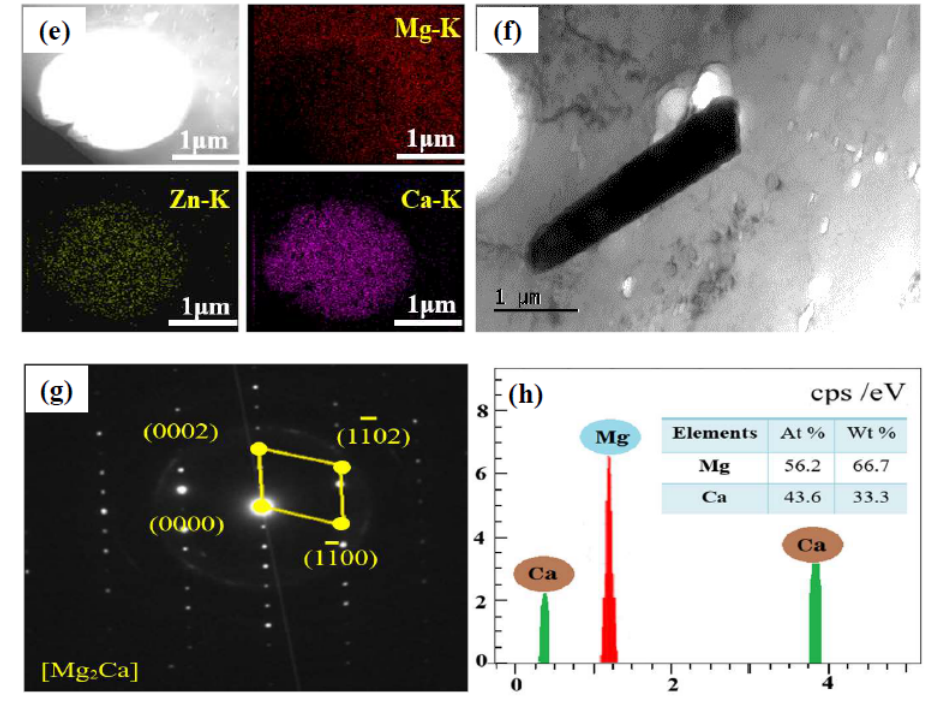
Figure 4. ( a , b ) Typical TEM phase features of as-studied MZM-1.10% Ca alloys; ( c ) TEM phase; ( d ) high resolution morphology; and ( e ) element distributions of Ca 2 Mg 6 Zn 3 marked in ( c ); ( f ) TEM phase; ( g ) selected area diffraction patters; and ( h ) EDS analysis of Mg 2 Ca phase marked in ( f